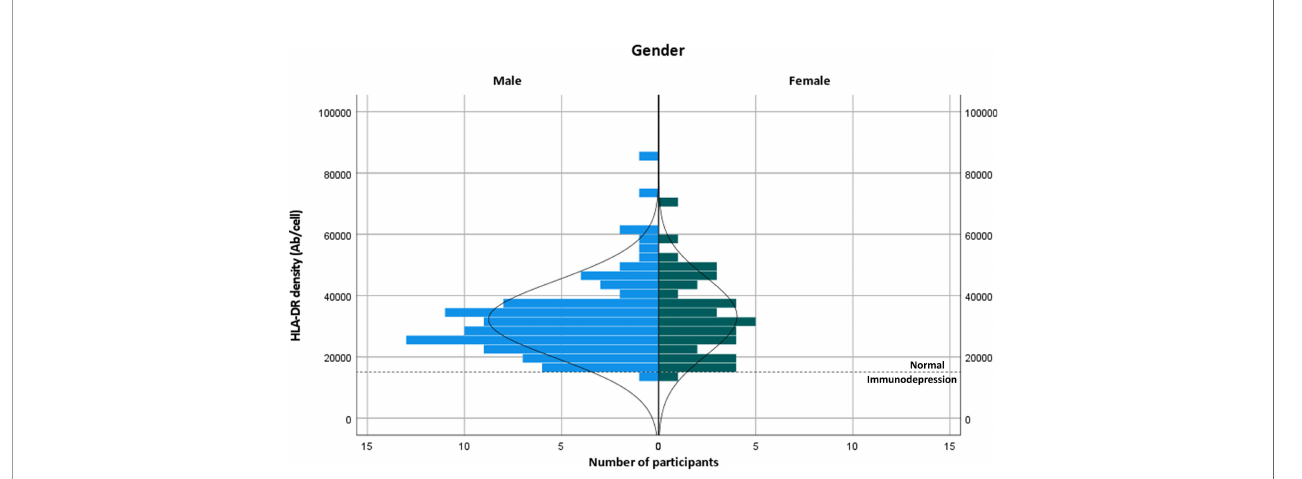
FIGURE 1 | Distribution of HLA-DR binding density in transplant recipients, strati fi ed by gender. The broken line indicates the cut-off for diagnosis of immunodepression as described in